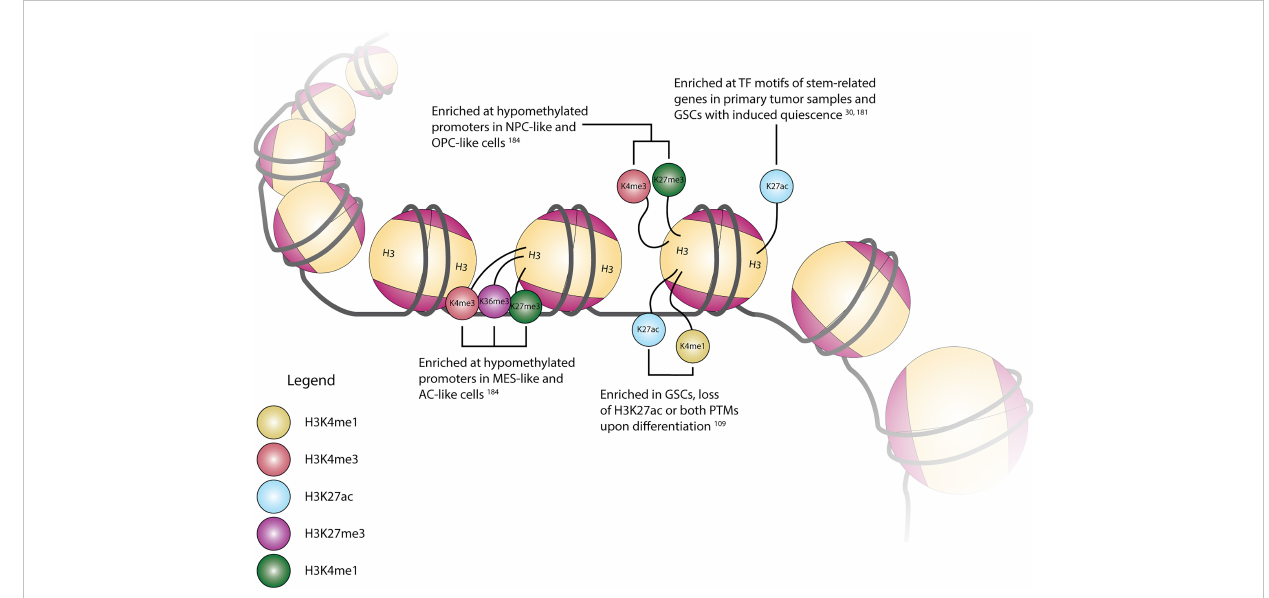
FIGURE 1 Cartoon depiction of common histone H3 modi fi cation locations and their associated modi fi cations, transcriptional state associations, and/or regulation in